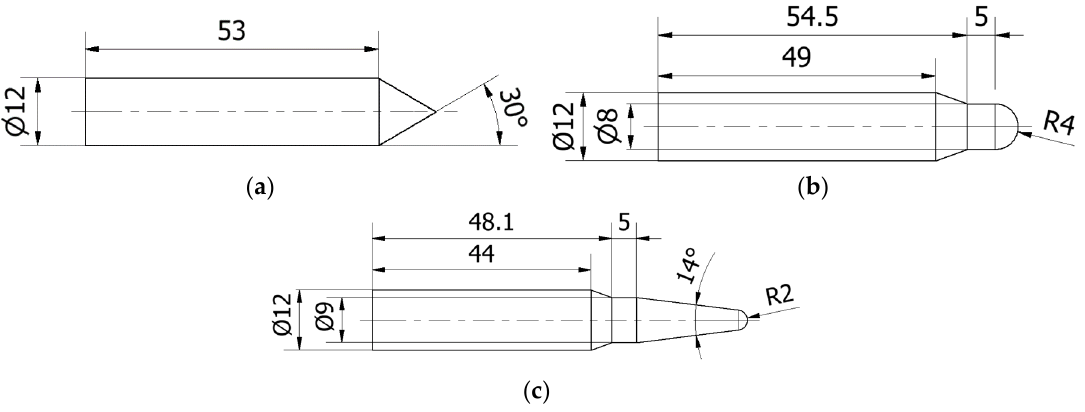
Figure A1. Geometries of the strikers: (a) conical, (b) hemispherical, (c) ogival.